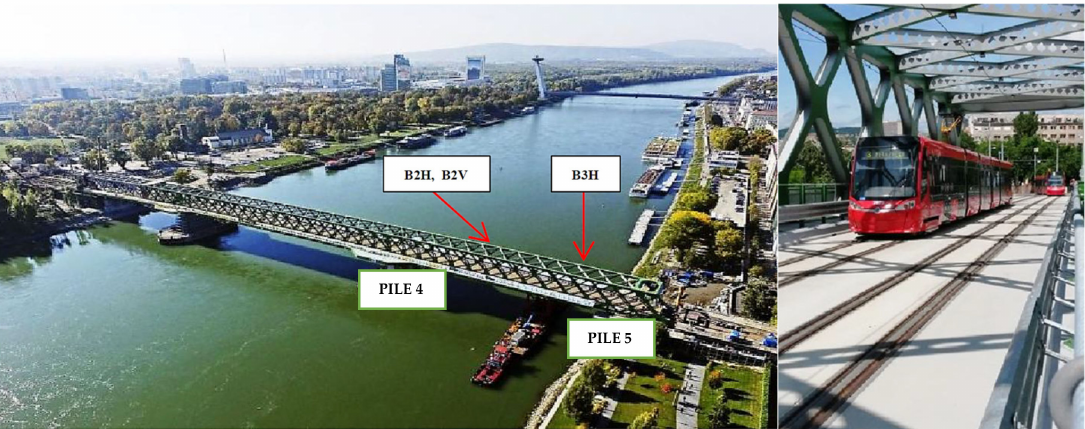
Figure 14. View of the reconstructed Old Bridge over the Danube in Bratislava and the tram line placed in the concrete roadway and its transverse